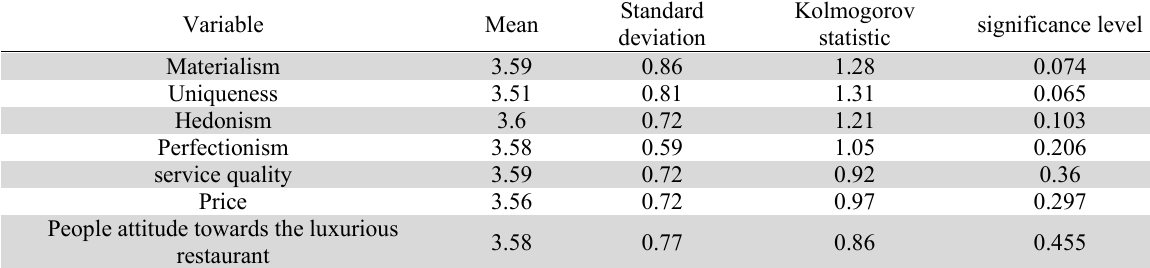
Descriptive statistics for research variables and Kolmogorov-Smirnov test